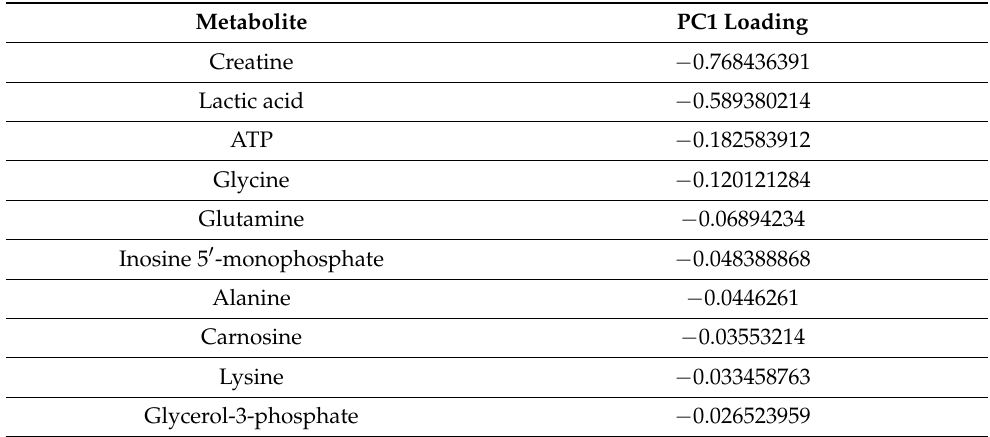
Figure 1. PCA score scatter plot ( A ) and the heat map ( B ). ( A ) Principal component scores are plotted. Purple: Sham-Vehicle, Blue: Sham-FTI, Red: Burn-Vehicle, Green: Burn-FTI. ( B ) SV: Sham-Vehicle, SF: Sham-FTI, BV: Burn-Vehicle, BF: Burn-FTI. Table 1. The top ten metabolites with the highest absolute factor loadings on the first principal component (PC1).